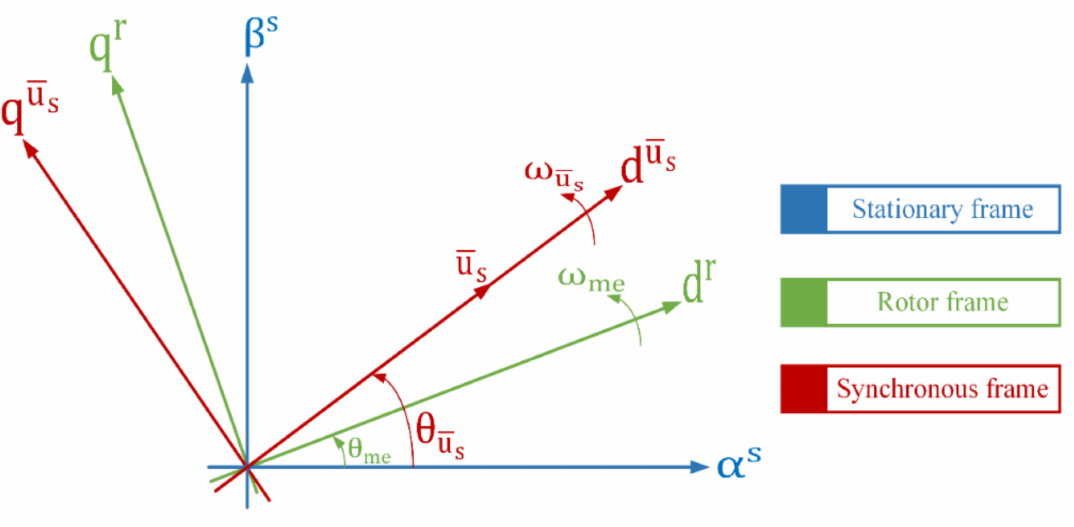
Figure 4. Relationships between reference